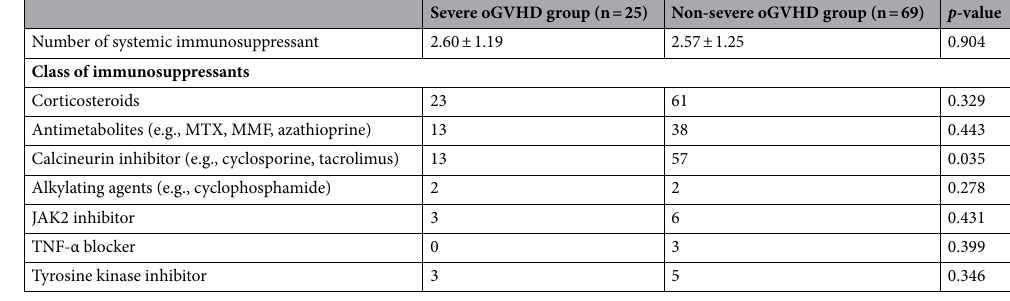
Table 4. Differences in systemic immunosuppressant for GVHD before ocular flare-up between severe and non-severe groups. MTX Methotrexate, MMF Mycophenolate mofetil, JAK Janus kinase, TNF Tumor necrosis factor, oGVHD Ocular graft-versus-host disease.